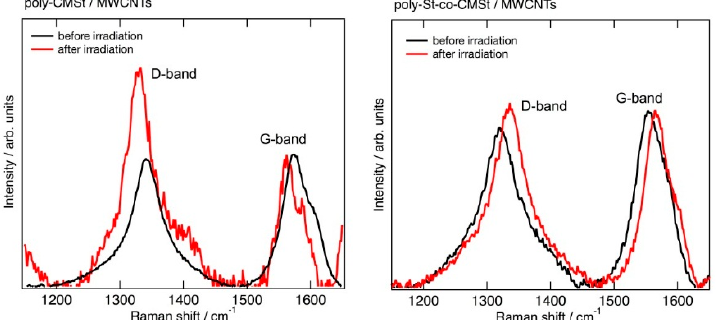
Figure 4. Raman spectra observed for poly(p-chloromethyl)styrene/multi-walled carbon nanotube (MWCNT) and styrene/p-(chloromethyl)styrene random copolymer/MWCNT mixtures before and after ultraviolet irradiation.